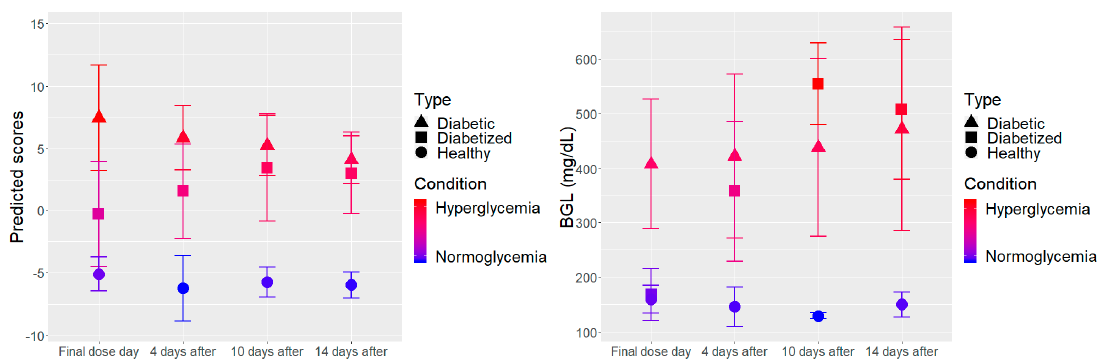
Figure 5. The mean score determined and the mean value of the measured blood glucose level for each group with the corresponding standard deviation are shown as a function of measurement days at the ( left panel ) and ( right panel ), respectively.